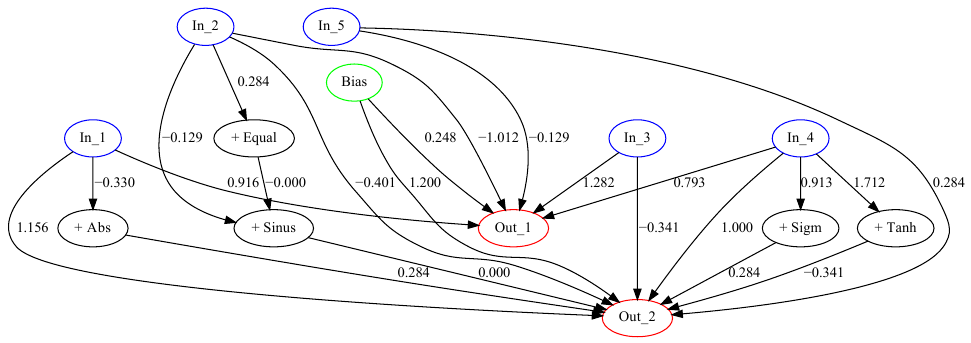
Figure 3. Graph of solution from run